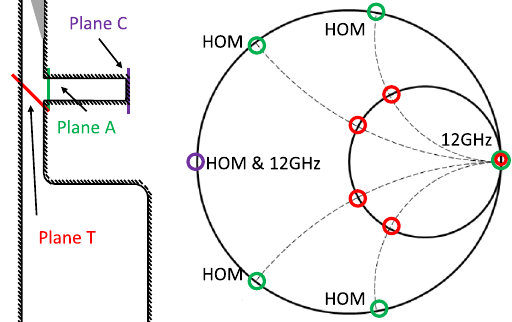
FIG. 3. Smith chart explanation. Blue: Impedance at the top surface of choke (reference plane C). Red: Impedance at the termination of choke (reference plane A). Green: Impedance at the junction plane of choke and radial line (reference plane T).